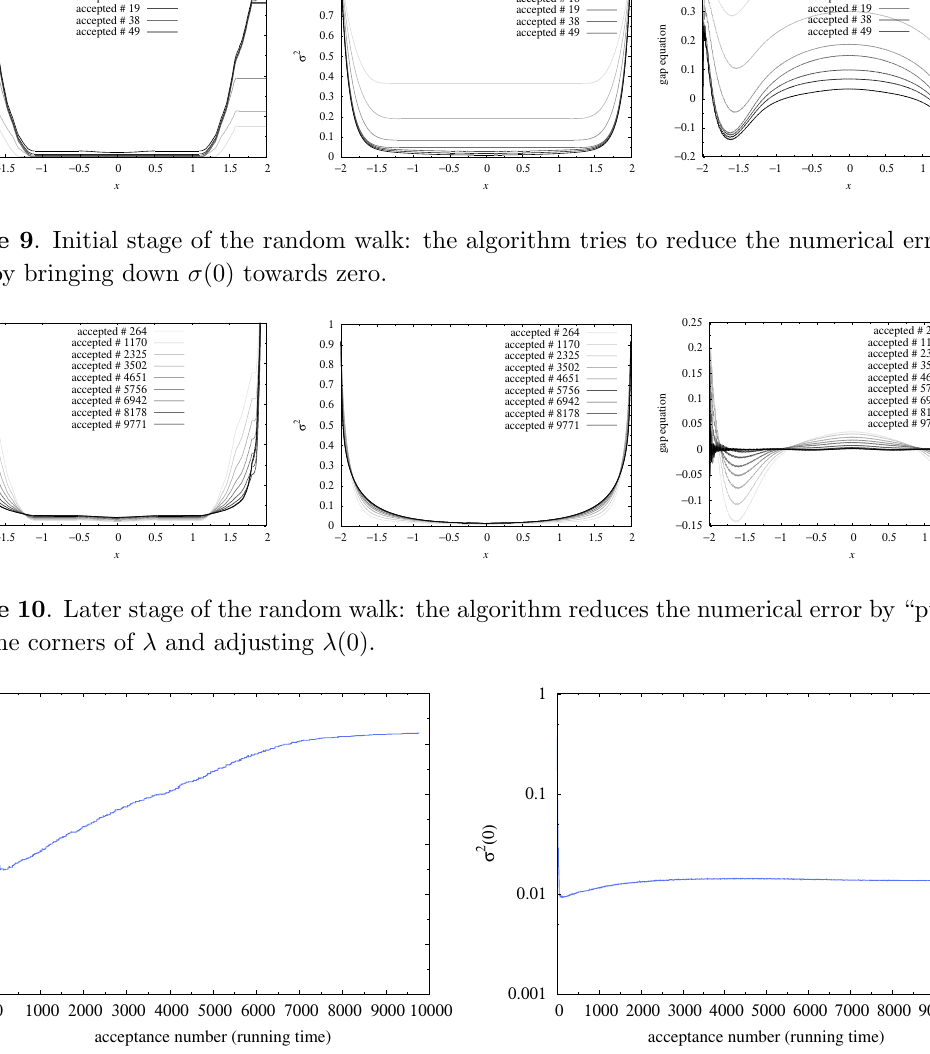
Figure 11 . The value of (cid:21) and (cid:27) at the midpoint of the string as functions of acceptance number (running